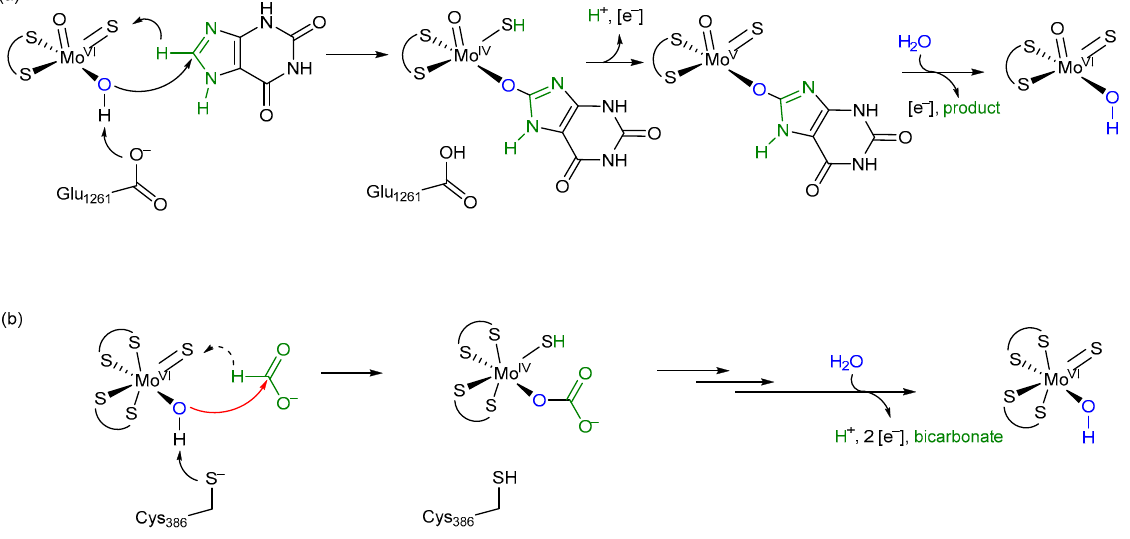
Figure 8. ( a ) The mechanism for xanthine oxidase adapted from Ref. [22]. ( b ) A tentatively proposed short mechanism for FDH operating via oxygen atom transfer. The similarity of the two substrates at the site of transformation is emphasized in green. The arrow shown in red constitutes the attack of the active site on the substrate which initiates OAT, which is immediately followed by a hydride or proton-coupled electron transfer to the sulfido ligand. In both mechanisms, the product is released (bicarbonate in the case of FDH) and water is bound to the active site.